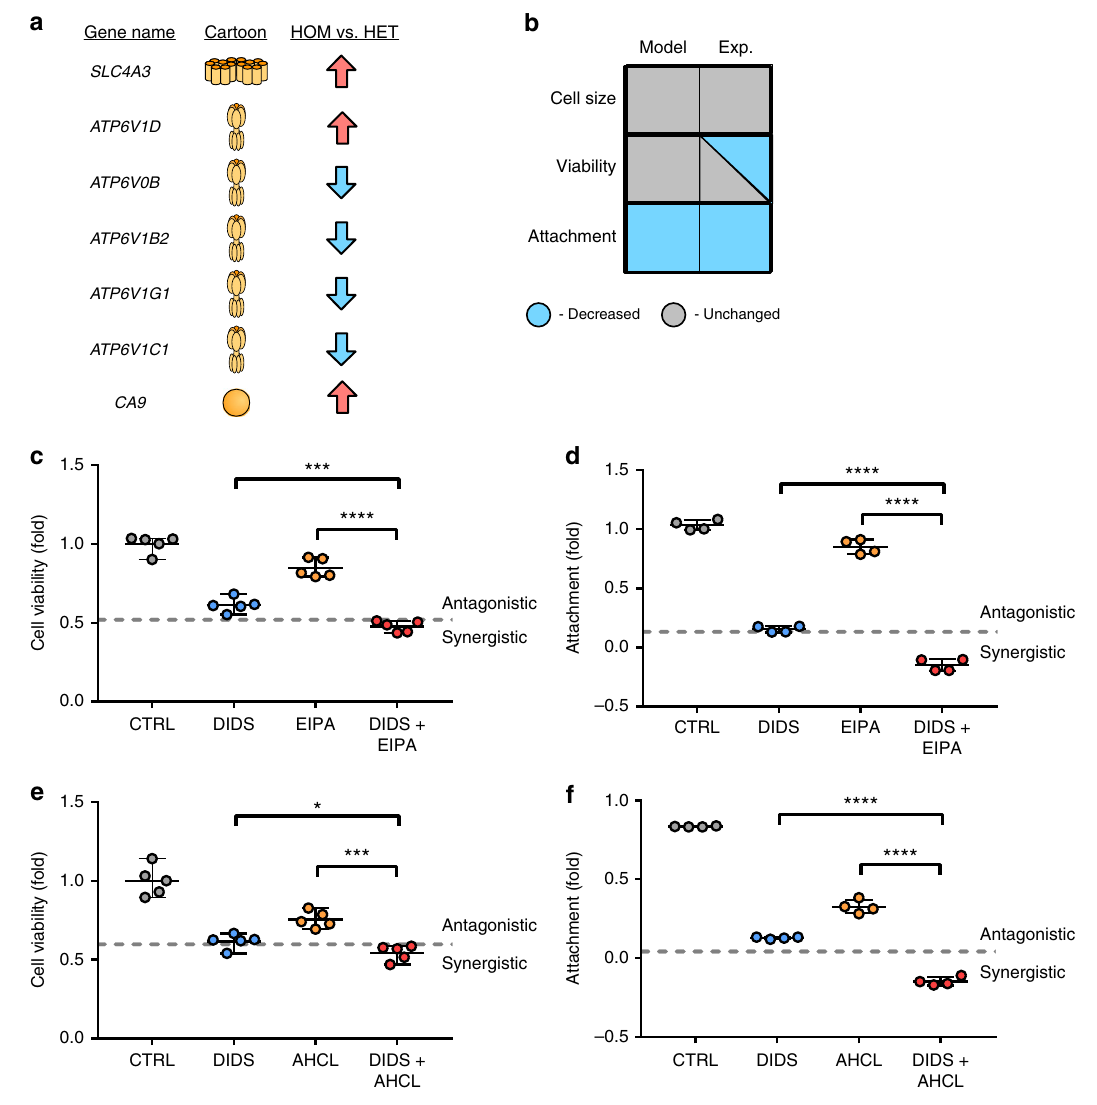
Fig. 5 Application of the qualitative network to murine embryonic fi broblasts. Expansion of the QN to p53 − / − , Kras G12D/ + (HET) and p53 − / − , Kras G12D/G12D (HOM) MEFs. a Transport proteins deregulated within HOM MEFs when compared to HET MEFs. Proteins are upregulated (red arrows), downregulated (blue arrows), or unchanged (grey). b Phenotype change for MEFS when HOM MEFs are compared to HET MEFs. The model output represents the physiological behaviour predicted by the model when proteins from ( a ) are deregulated in the model in the same manner as in the gene array. Experimental phenotype represents behaviour reported previously 42 , where it is known. The model predicts that attachment will be signi fi cantly different between the two cell types, but viability and cell size will remain unchanged. c Effects of application of channel inhibitors to HOM MEFs in vitro showing application of 10 µ M DIDs for 72 h, resulting in decreased cellular attachment (left), and application of 10 nM EIPA ± 10 µ M DIDs (right). Data are technical replicates. Dotted lines represent calculated Bliss independence values. d Effects of application of 10 µ M DIDs ± 10 nM EIPA on viability in HOM MEFs. e Effects of application of 10 µ M DIDs ± 10 nM AHCL on attachment in HOM MEFs. f Effects of application of 10 µ M DIDs ± 10 nM AHCL on viability in HOM MEFs. * P < 0.05, *** P < 0.001, using two tailed unpaired t -test. Error bars represent standard deviation. Shown are 5 replicates ( c ), and 4 replicates ( d – f